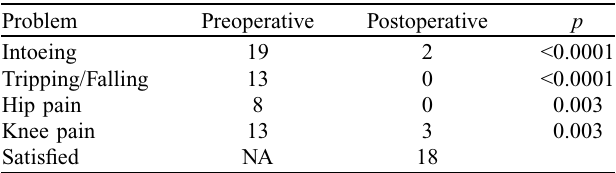
Table 3. Patient/Parent reported outcome